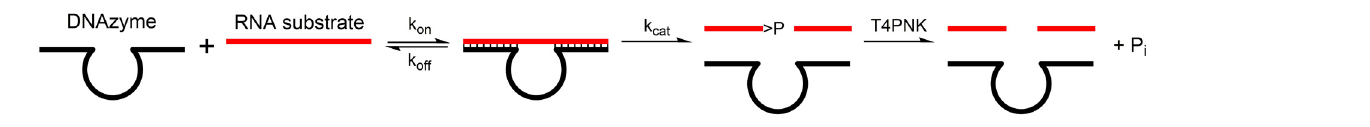
Fig 3. Kinetic model of DNAzyme reaction resulting in a product with a 2 ’ ,3 ’ -cyclic phosphate ( > P).